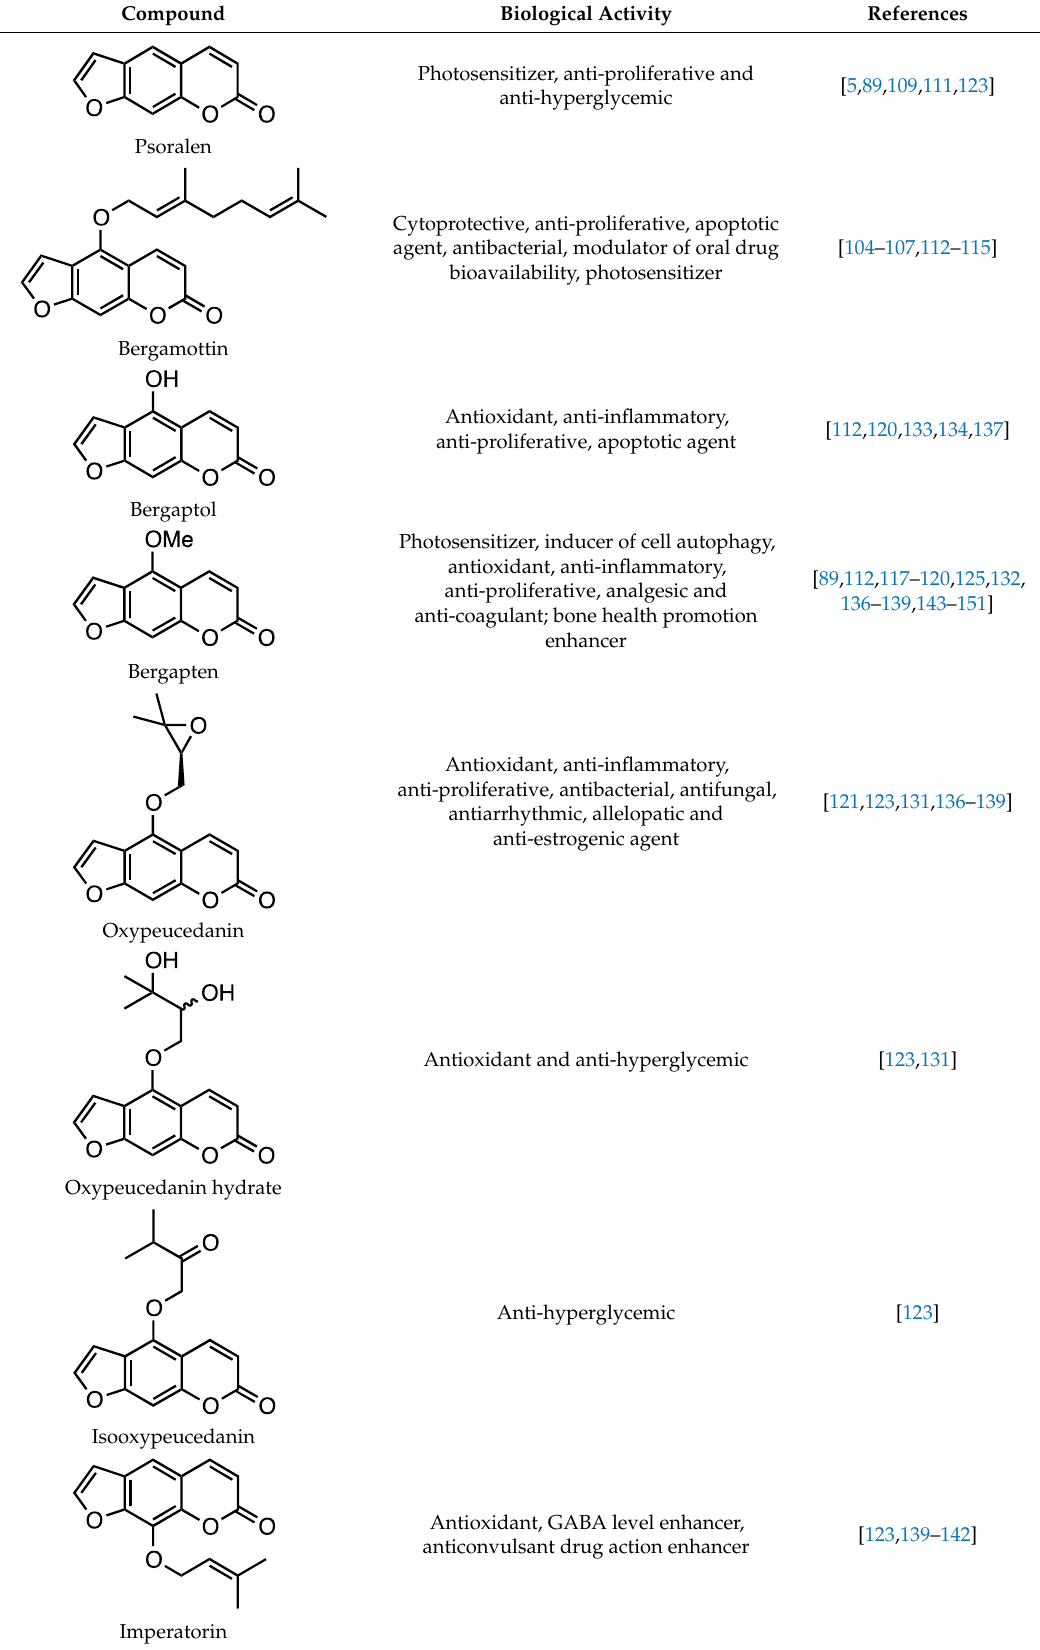
Table 1. Compounds described in the present review article, and their biological activities discovered to date.